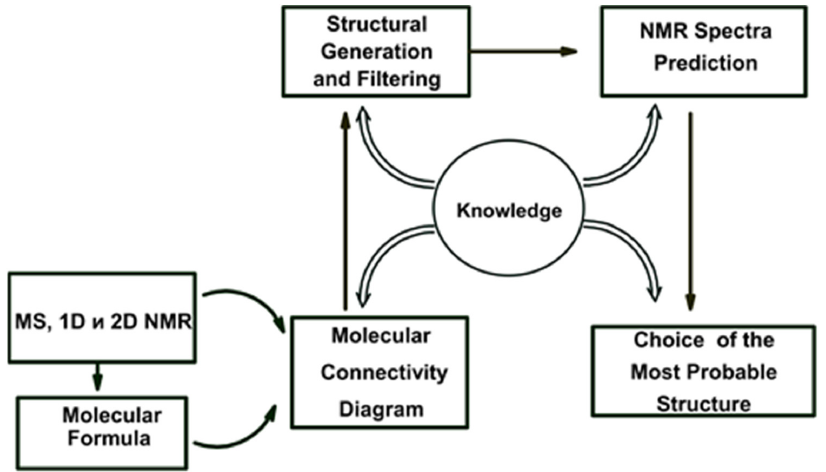
Figure 2. A simplified flow diagram for ACD/SE_v2 based on 1D and 2D NMR spectra. Possible data that could be utilized in v2 were a molecular formula, 1 H & 13 C 1D NMR, and 1 H- 1 H COSY, 1 H- 13 C HSQC (or HMQC), 1 H- 13 C HMBC and 1 H- 15 N HMBC 2D